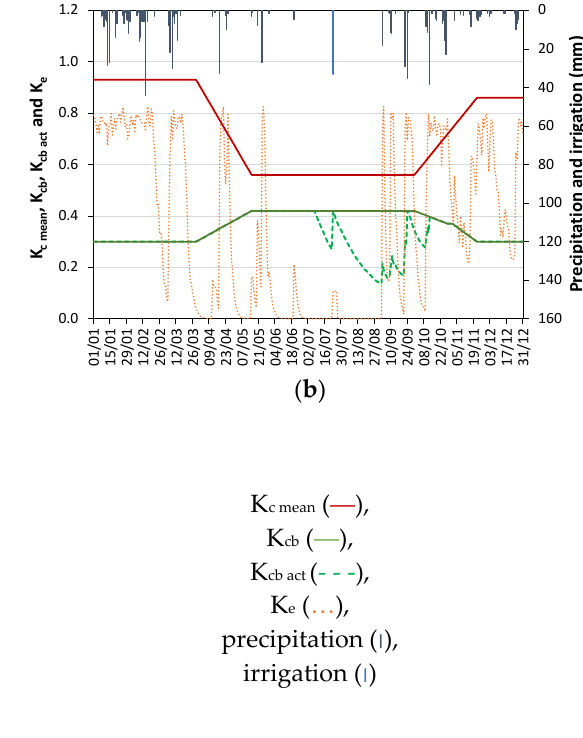
Table 4. Goodness-of-fit indicators relative to the comparison between simulated transpiration (T c act ) and the correspond- ing values obtained from sap-flow measurements (T SF field ).